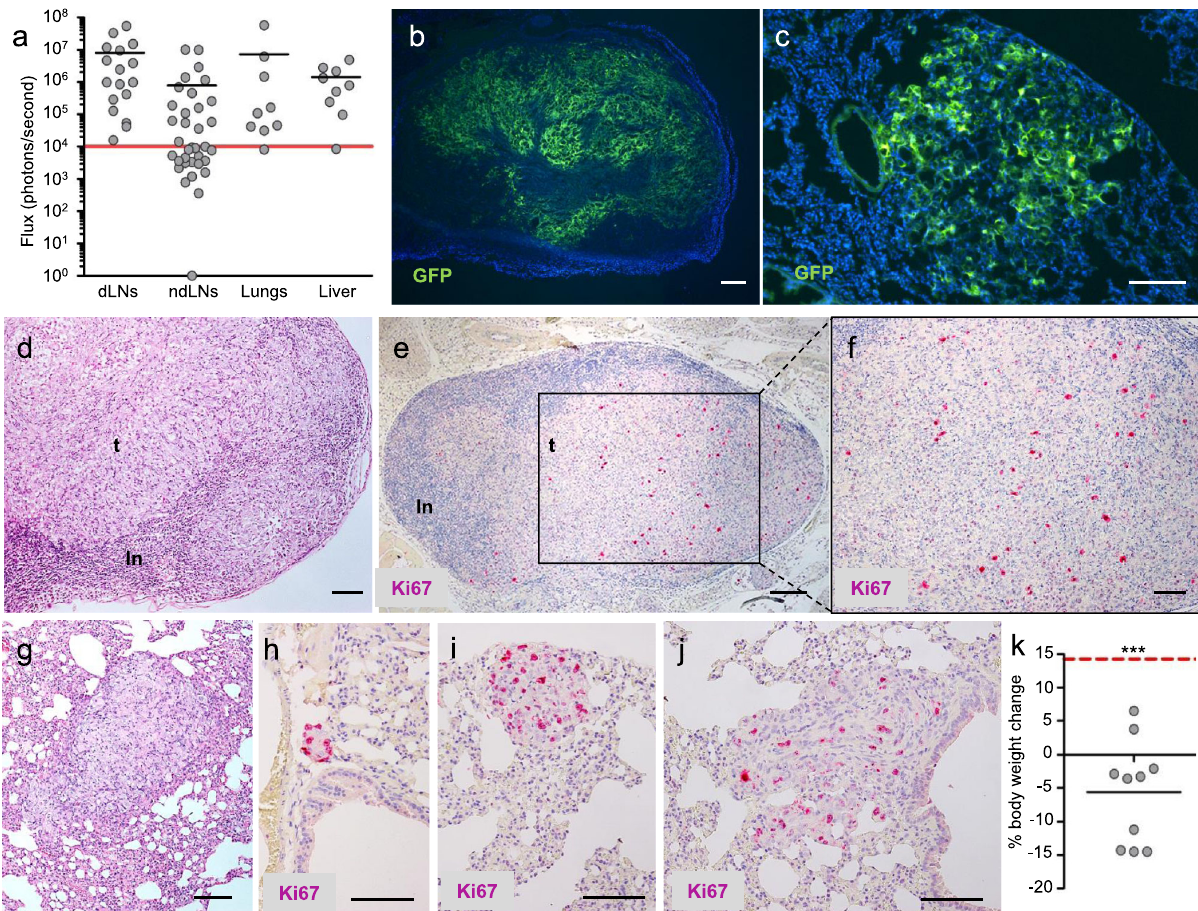
Fig. 2 Features of metastases in A3250 xenograft model. a Metastatic burden in organs as indicated, determined by bioluminescent imaging (total Flux) ex vivo, 6 weeks post-injection ( n = 9 mice). Inguinal draining lymph nodes (dLNs; n = 17), axillary and brachial non-draining lymph nodes (ndLNs; n = 35). Solid black lines indicate mean values. Red solid line indicates the threshold of positive Fluc signal above background. Representative images of lymph node ( b ) and lung ( c ) metastases (GFP, green) in tissue sections (DAPI, blue). Metastases in the lymph node stained by H&E ( d ) or Ki-67 proliferation marker ( e , f ). Lung metastases stained by H&E ( g ) or Ki-67 ( h – j ). Different sizes of metastases are depicted ( h – j ). k Weight loss of mice bearing A3250 tumors at six-week endpoint ( n = 10 biologically independent mice). Differences between the true means were determined through a one-sample t test ( p < 0.0001). Short black line indicates mean % weight loss. Red dotted line indicates the average weight gain of an age-matched, naïve control mouse during the same period. p value was determined by one sample t test. Images are representative of two independent experiments. n = 5 biologically independent mice. *** p < 0.001. Scale bars: b , e , 200 μ m; c , d , f – j , 100 μ m. Source data are provided as a Source Data fi